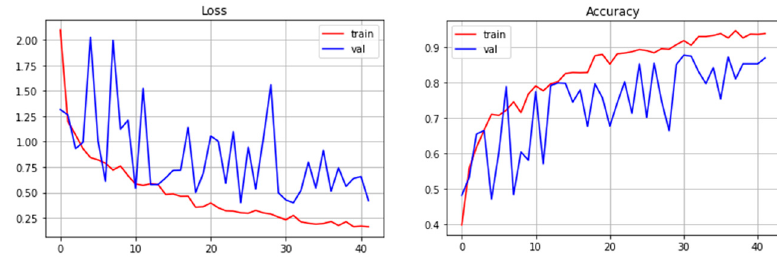
Figure 10. Graphs showing the learning process.